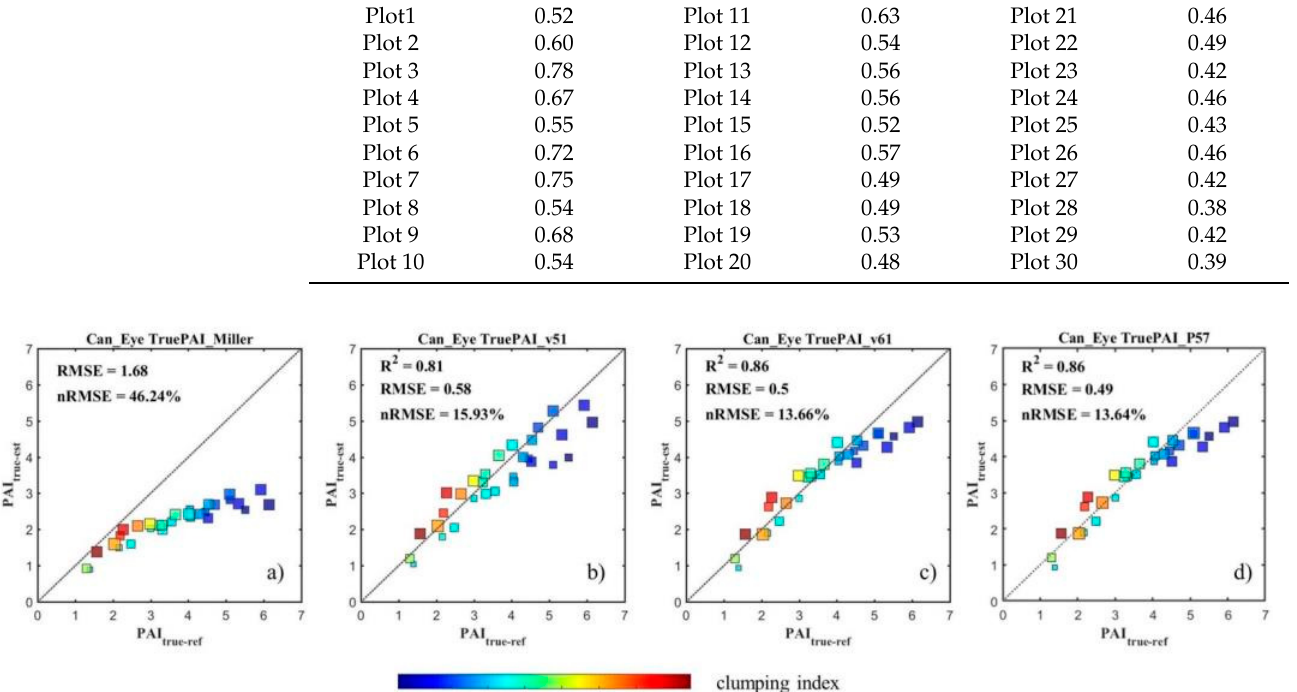
Figure 7. PAI true results from Can_Eye using different algorithms including the ( a ) Miller ( b ) v5.1 ( c ) v6.1, and ( d ) P57 algorithm; the best result was produced by the Can_Eye P57 algorithm. A smaller symbol indicates a smaller average leaf inclination angle (ALA), while a larger symbol indicates a higher ALA.